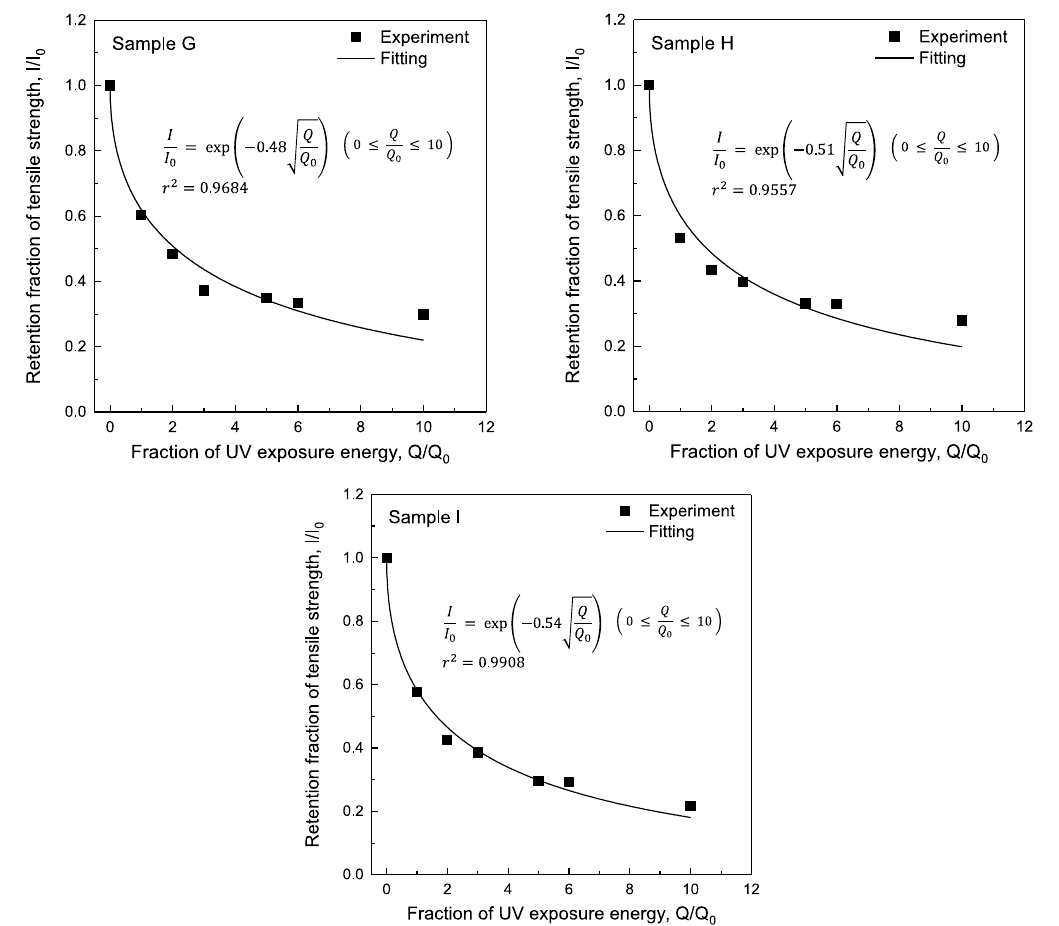
Figure 7. Relationship between a fraction of UV exposure dosage and retention fraction of tensile strength of Samples A to I. Symbols represent experimental data, and a solid line represents the fitting data by Equation (3).